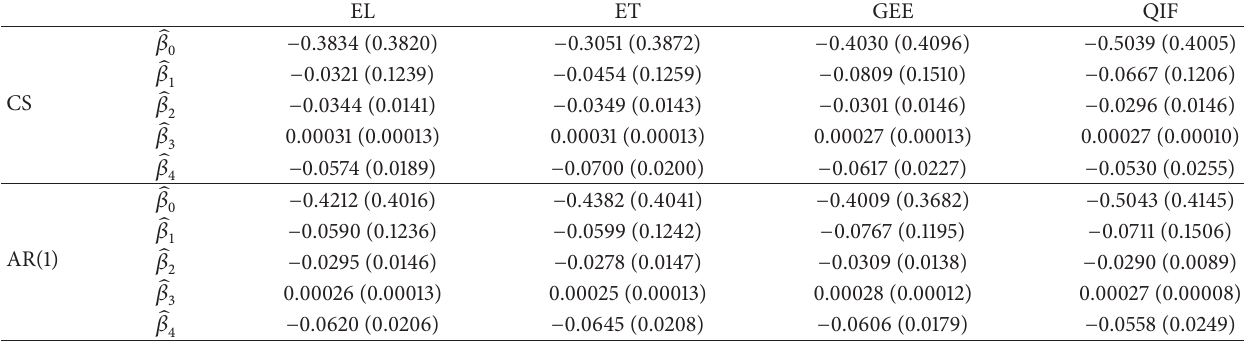
Table 2: The parameter estimators (the corresponding standard errors) for CS and AR(1) correlation structures.